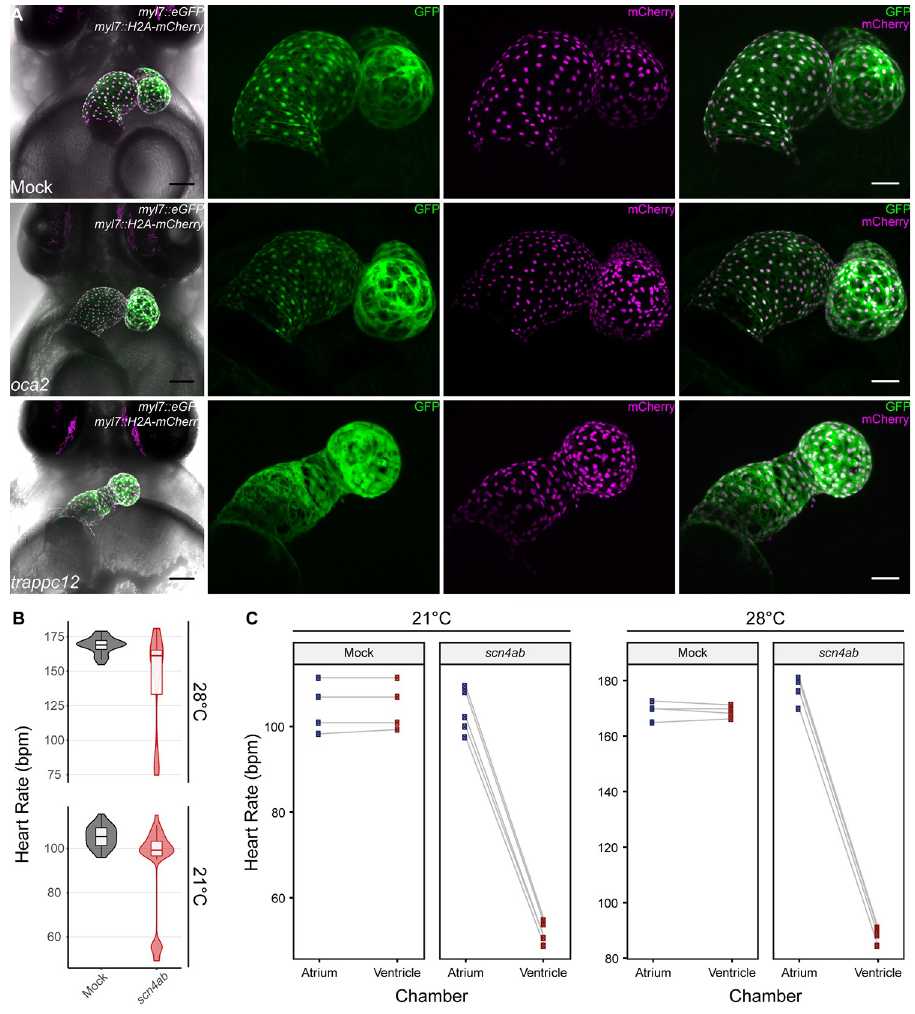
Fig 4. Heart looping defects and cardiac arrhythmia in medaka crispant embryos. (A) Confocal images (mirrored) of hearts of mock-injected, oca2 and trappc12 crispants of the myl7 :: eGFP myl7 :: H2A-mCherry reporter line (7 dpf); note the heart looping defect observed in trappc12 crispants. Scale bars: 100 μ m (First panel on left) and 50 μ m (blow- up images). (B) Heart rate measurements (beats per minute, bpm) of GFP -injected (Mock; dark grey; n = 22) and scn4ab crispant (red; n = 32) embryos (4 dpf) at 21 and 28˚C; note the bimodal distribution in scn4ab crispants. (C) Paired plots showing heart rate scores for each chamber separately (atrium in blue; ventricle in red) of individual embryos from B at both